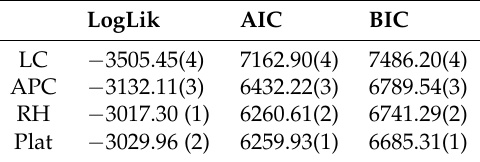
Table 4. Model comparison for UK